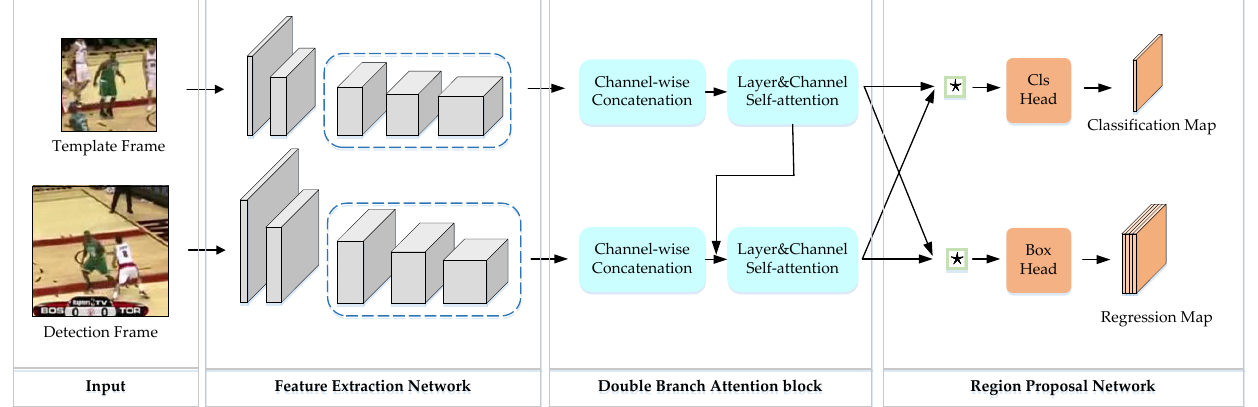
Figure 1. The schematic diagram of DBA-Siam. It includes Input, Feature Extraction Network, Double Branch Attention block, and Region Proposal Network where ⋆ stands for cross-correlation operation. The template frame contains a single target and part of the background, and the detection frame is the video frame that needs to search for the target.